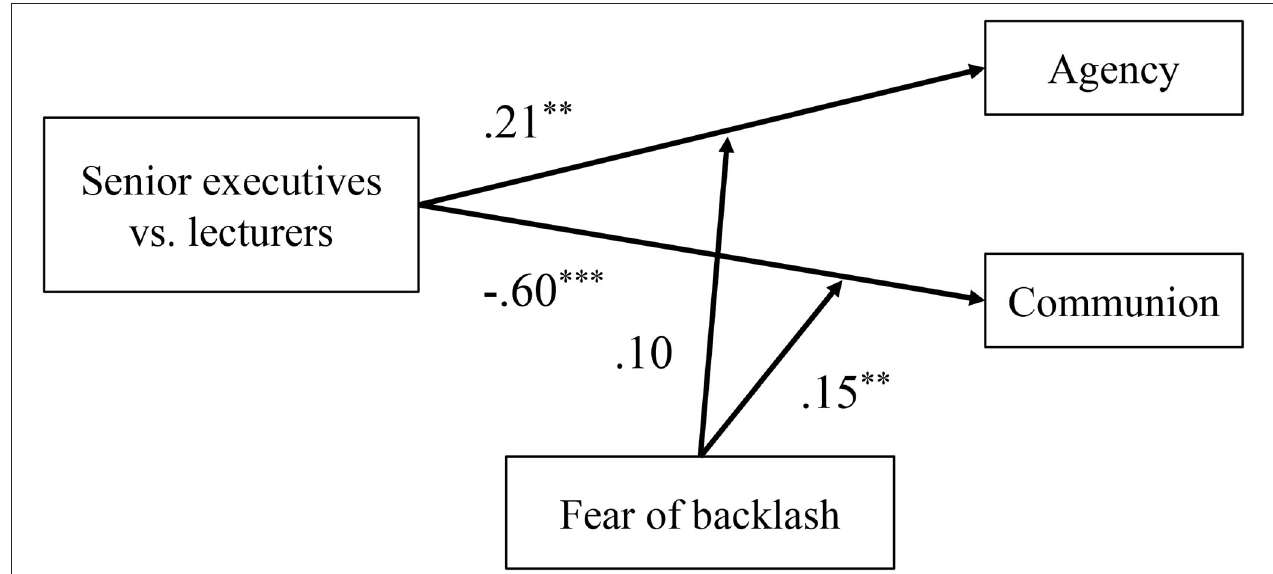
FIGURE 4 | Standardized regression coefficient for moderation effect of fear of backlash between role types and self-reported agency and communion in Study 2. Role type was recoded as 1 = senior executive, 0 = lecturer. The “ + ” sign represents positive relationship and effect and —represents negative relationship and effect. All values of variables are Z -standardized. ** p < 0.01, *** p < 0.001. N = 207